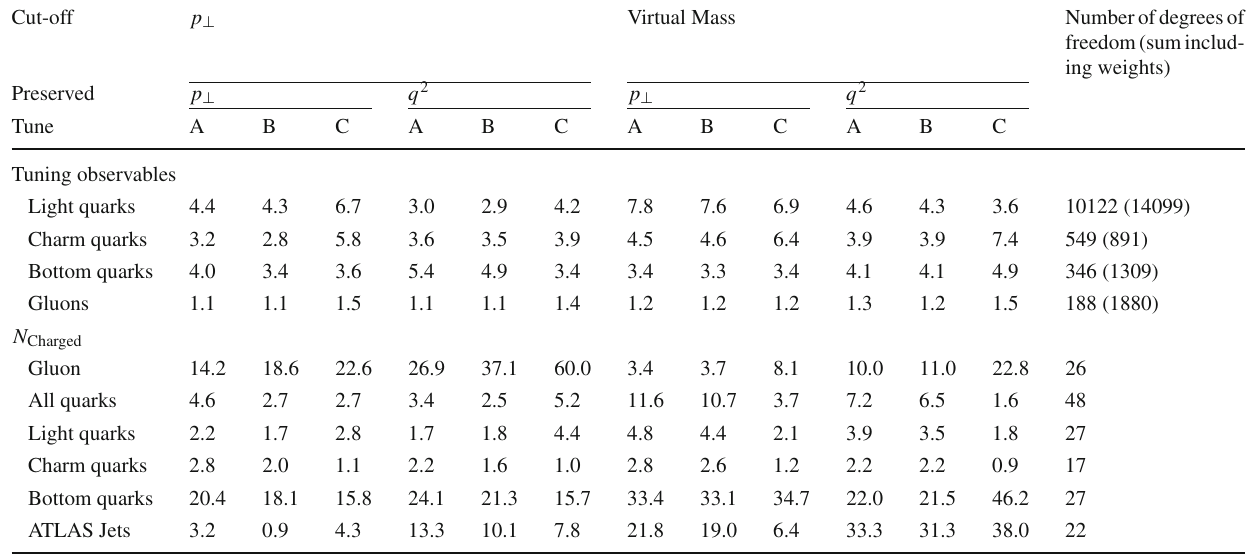
Table 2 The values of χ 2 per degree of freedom obtained in the fit for different choices of the cut-off option, the preserved quantity in the shower and weight of the charged particle multiplicity data. The values are χ (cid:9) 2 as described in the text for the tuning observables, normalised to